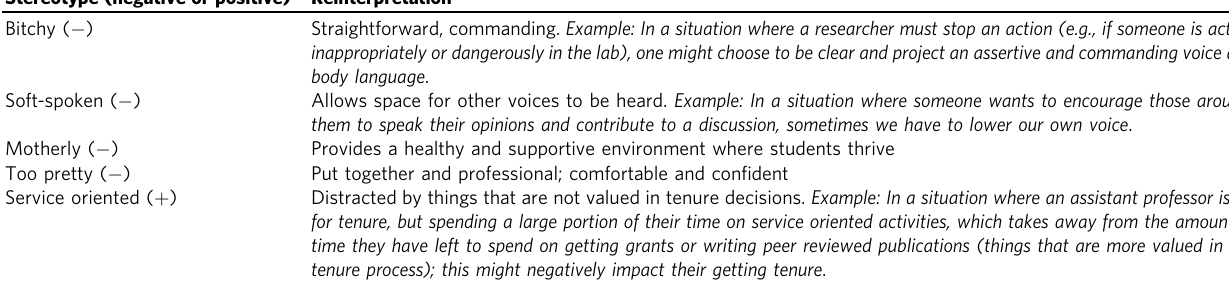
stereotypes and effectively reinforce gender inequality (Derks